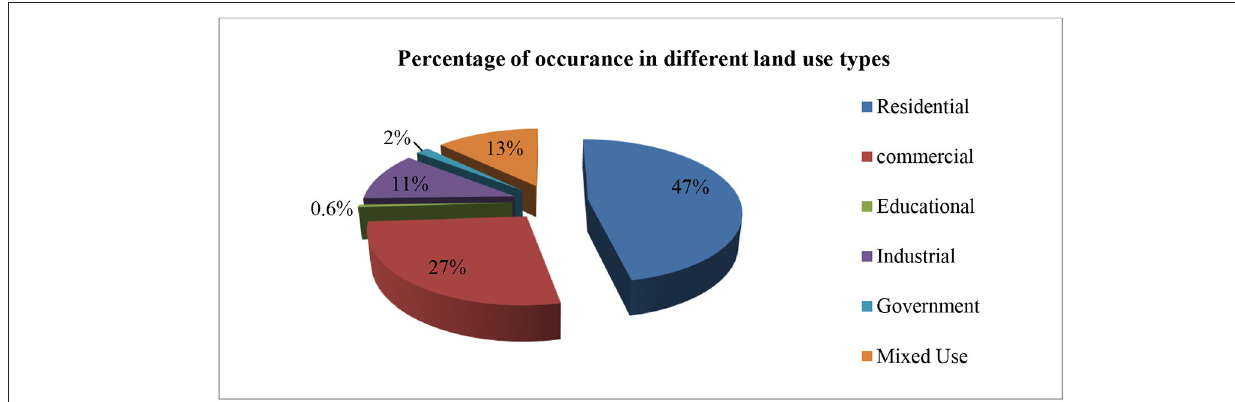
FIGURE 3 | Percentage of fire hazards in different types of land use.